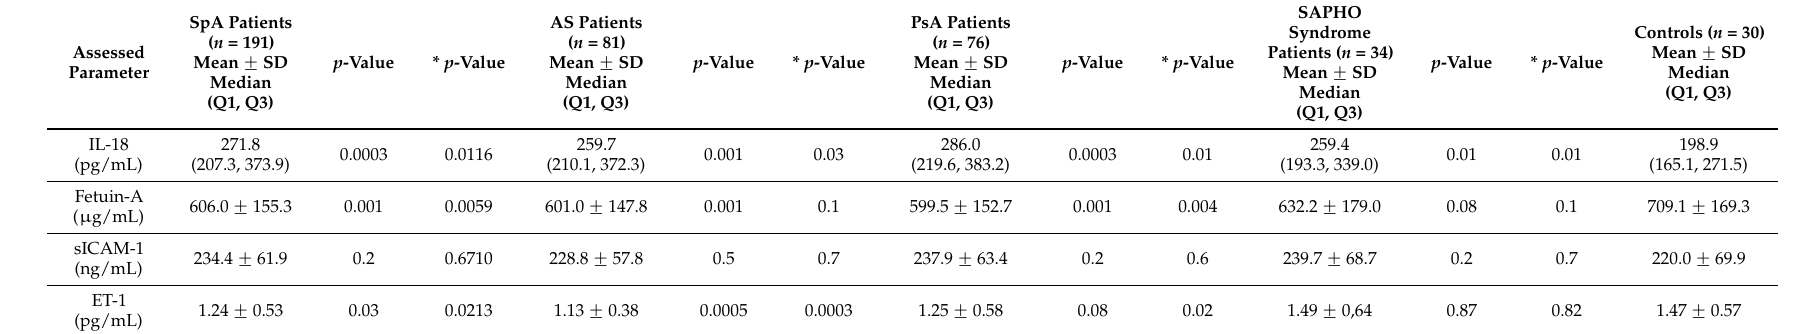
Table 2. Serum levels of markers of endothelial function in spondyloarthritis patients groups in comparison to